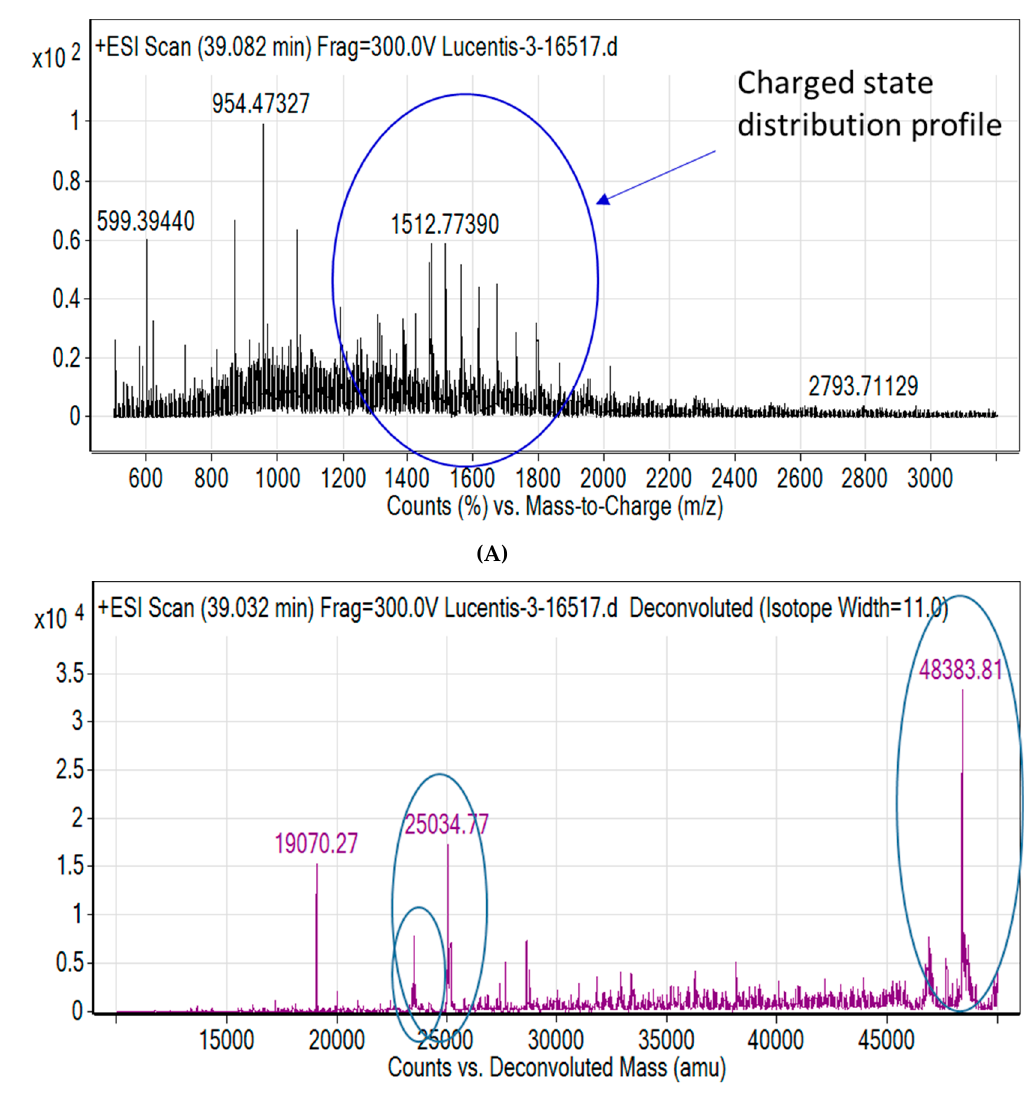
Figure 3. The LC/MS analysis of fab ( A ) Mass spectrum ( B ) De-convoluted mass spectrum. The circled peaks show the parent molecules, heavy chain and light chain respectively.